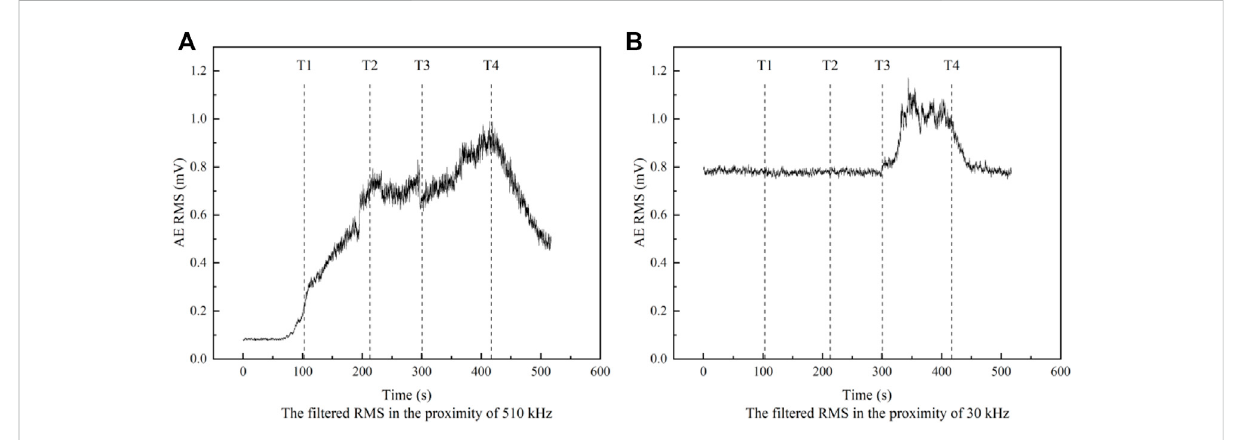
FIGURE 6 Filtered RMS in the proximity of (A) 510 and (B) 30